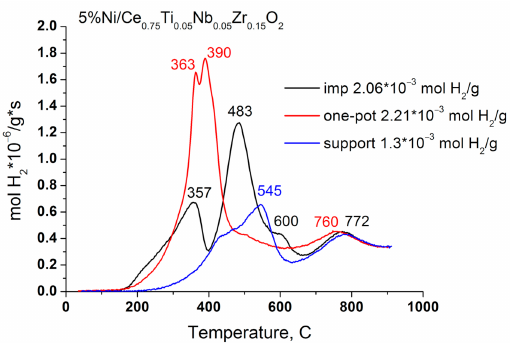
Figure 4. H 2 –TPR curves obtained for impregnated and one-pot NiCeTiNbZr